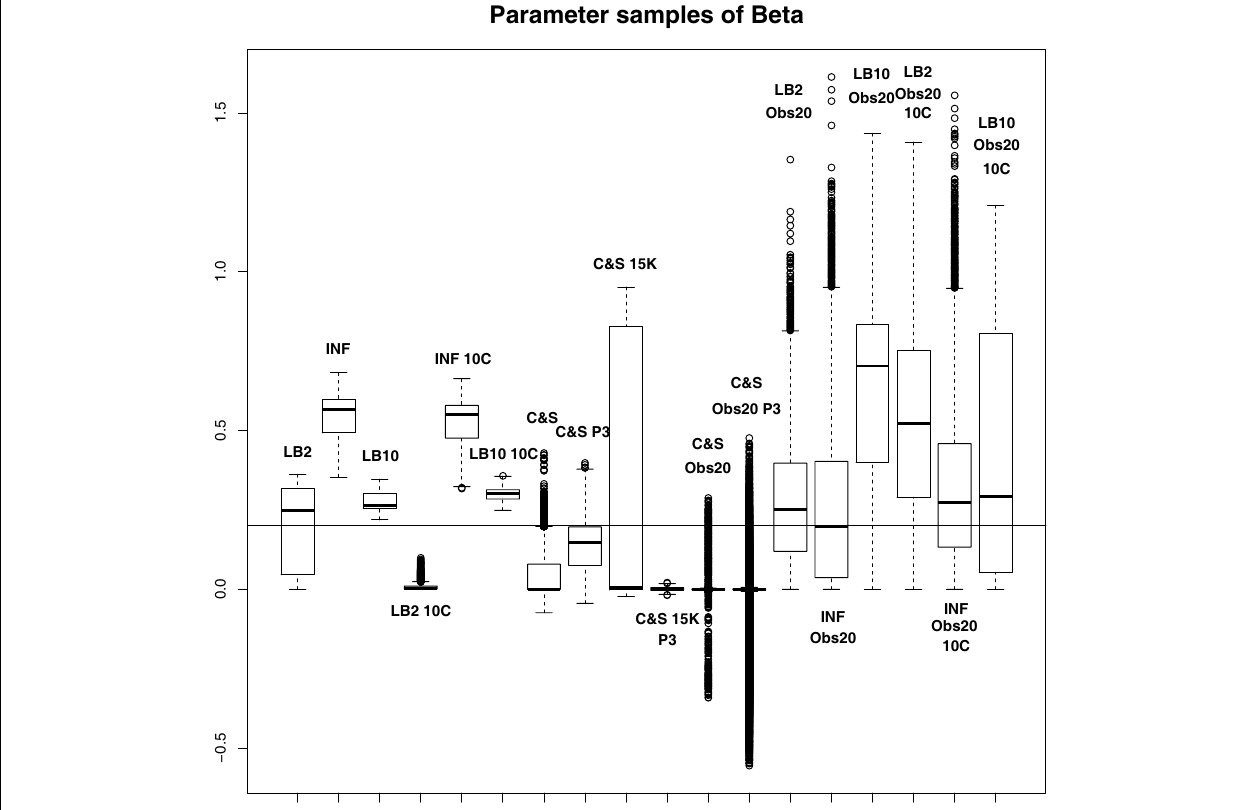
FIGURE 9 | Average posterior distributions of parameter (cid:12) from equation (62) over 3 datasets . From left to right: LB2, INF, LB10, LB2 10C, INF 10C, LB10 10C, C&S, C&S P3, C&S 15K, C&S 15K P3, C&S Obs20, C&S Obs20 P3, LB2 Obs20, INF Obs20, LB10 Obs20, LB2 Obs20 10C, INF Obs20 10C, and LB10 Obs20 10C. The solid line is the true parameter. For definitions, see Tables 3 and 4 . For an explanation of the boxplot form, see the beginning of Section 6. Figure reconstructed from Macdonald and Husmeier